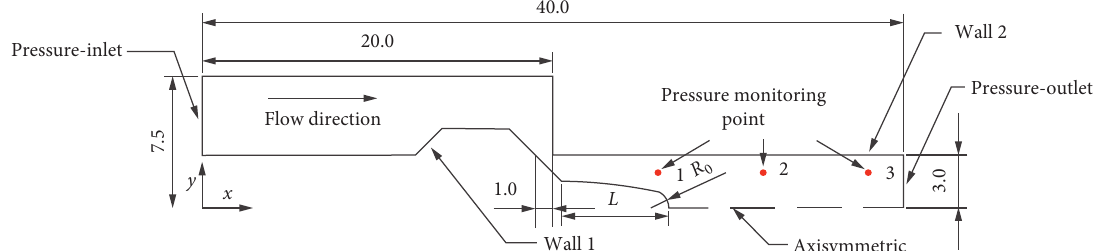
Figure 1: Numerical model of the regulating valve.